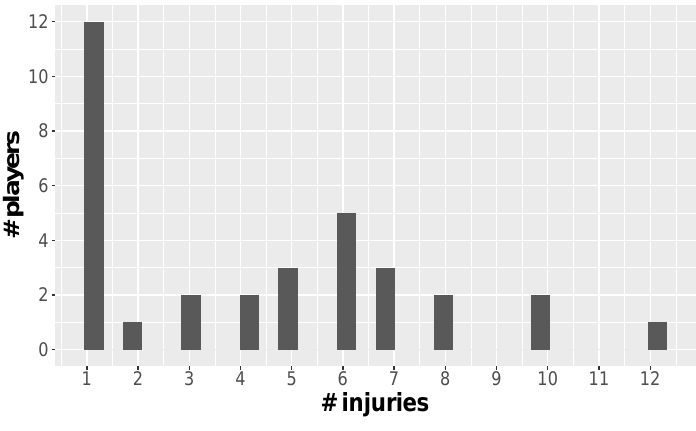
Figure 1. Number of injuries per